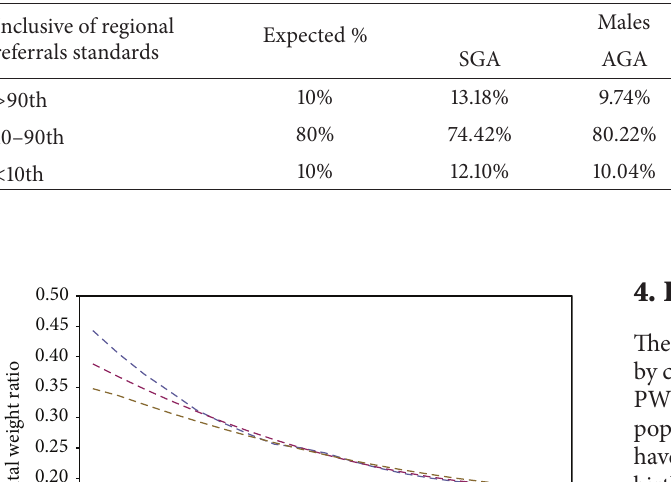
Table 1: Placenta weight ratio distributions for SGA, AGA, and LGA infants based upon the inclusive of regional referrals standards.